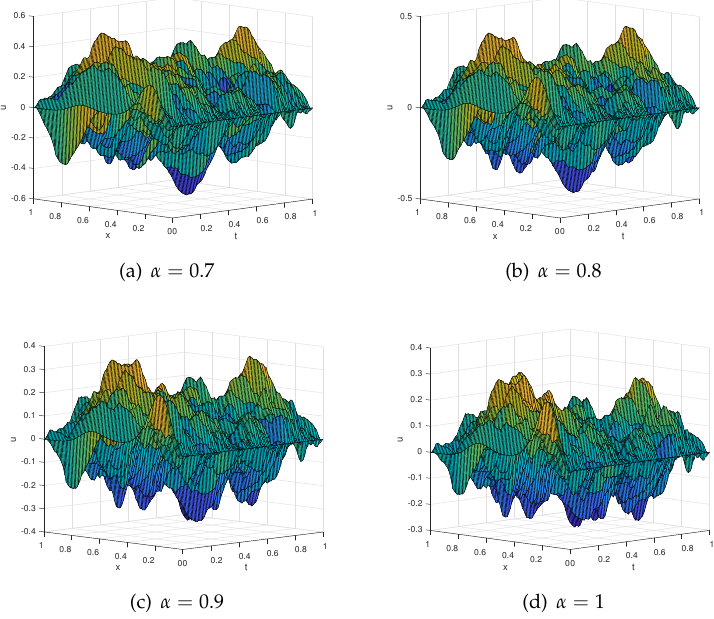
Figure 7. The approximation solutions of Example 2 (case (2)) with σ =